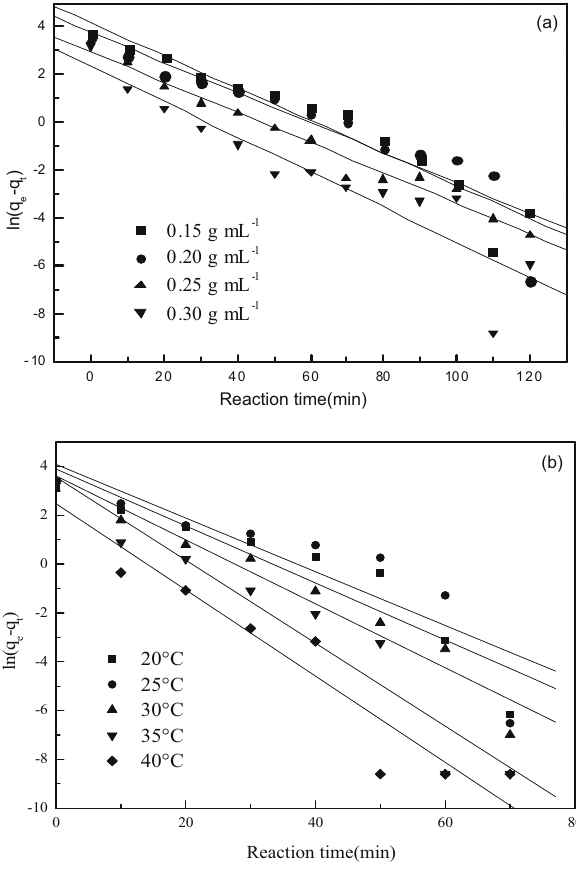
Figure 4: Pseudo - fi rst - order plots of GPC adsorption on resin 001 × 7 at di ff erent ( a ) adsorbent dosages and ( b )